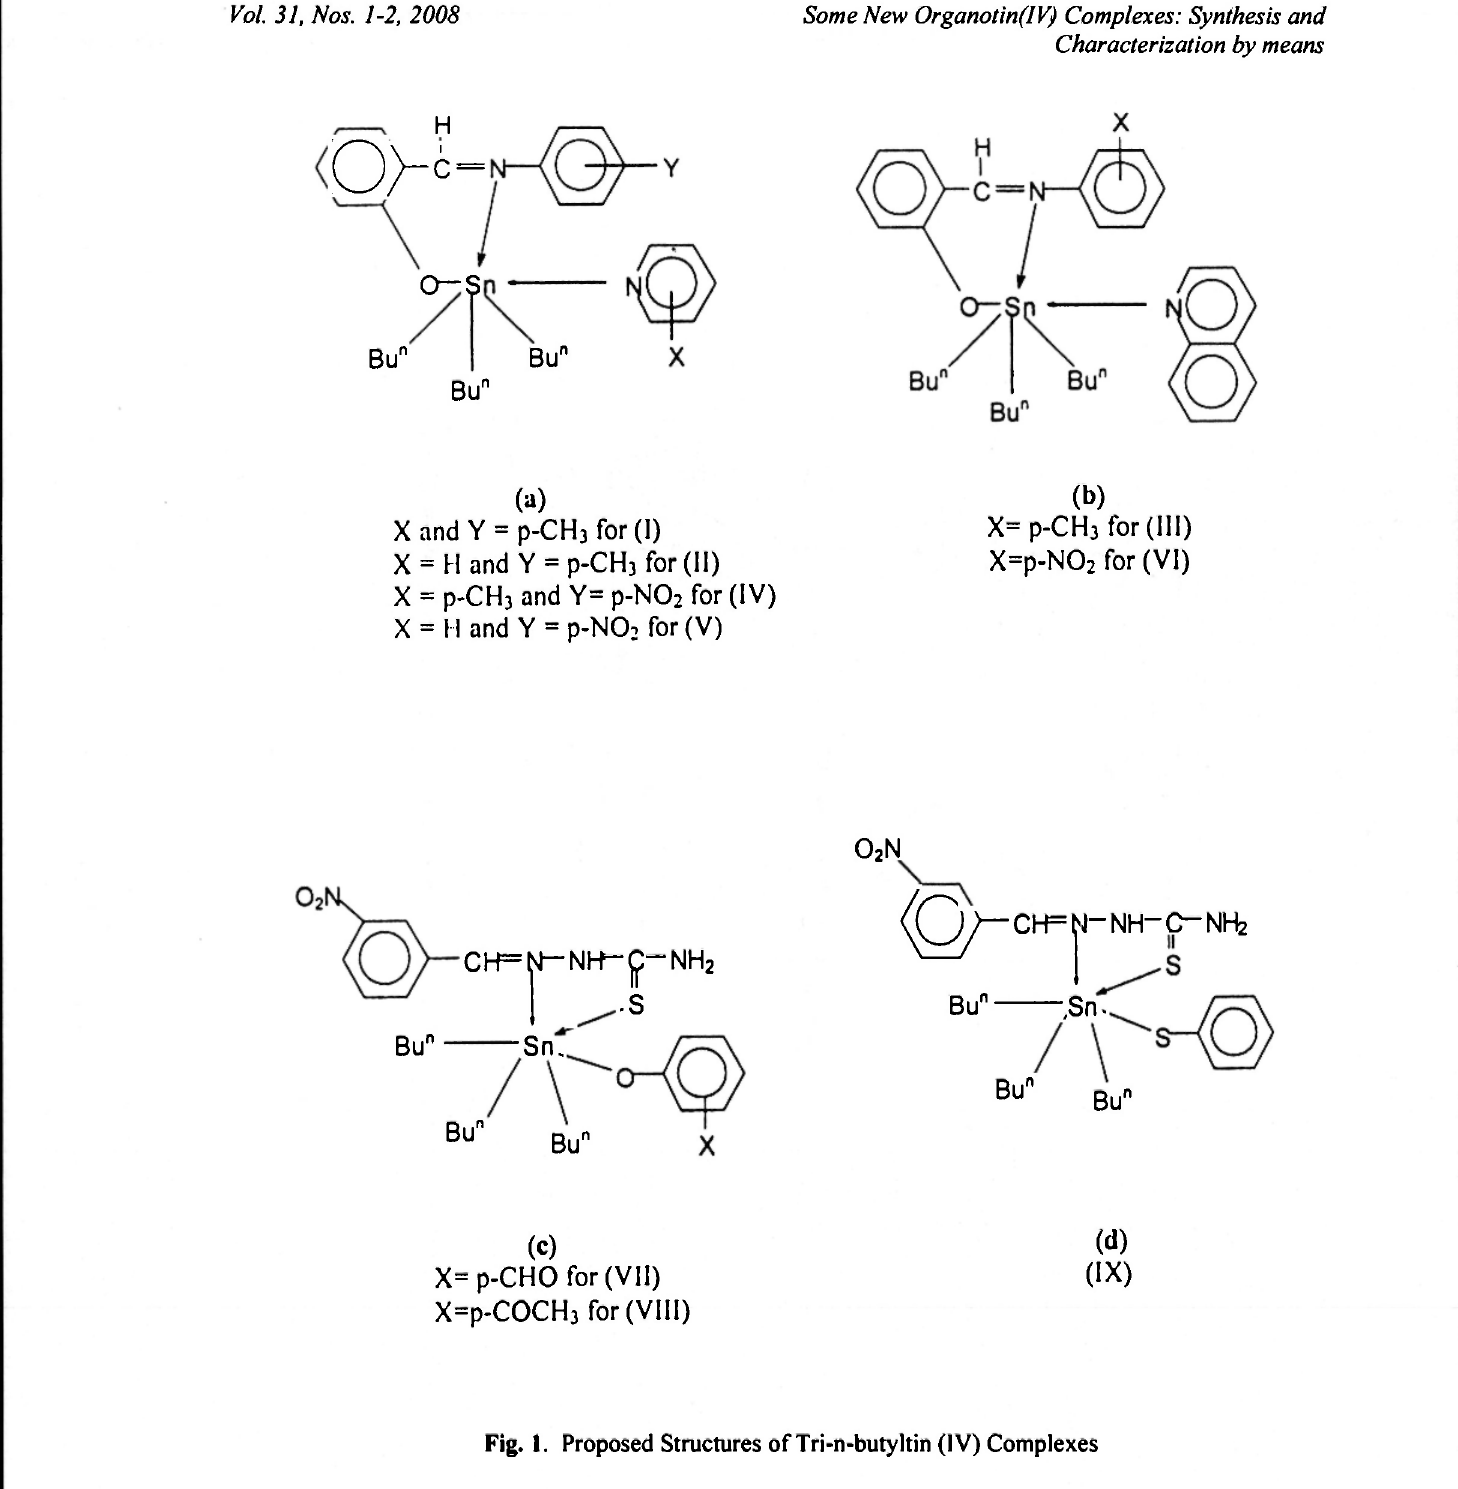
Fig. 1. Proposed Structures of Tri-n-butyltin (IV)